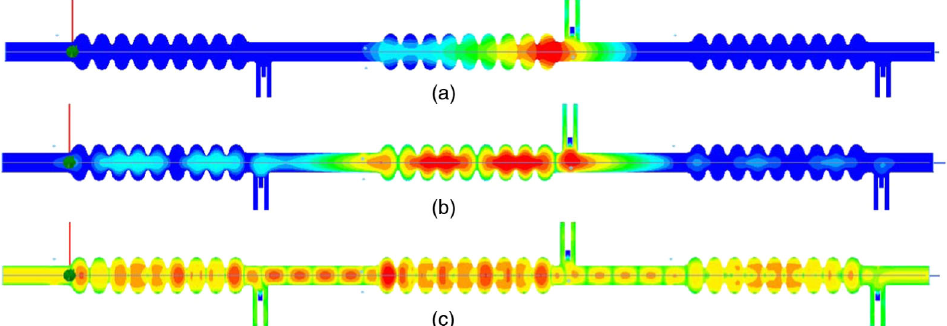
FIG. 2. Trapped modes in the infinite chain of third-harmonic cavities with a random HOM spectrum: (a) type I high- Q HOM is localized within the cavity volume, (b) type II medium- Q HOM occupies the cavity and adjacent beam pipes, and (c) type III low- Q HOM distributed along the cavity chain. All plots show the complex magnitude of the electric field, where a blue color corresponds to zero amplitude.